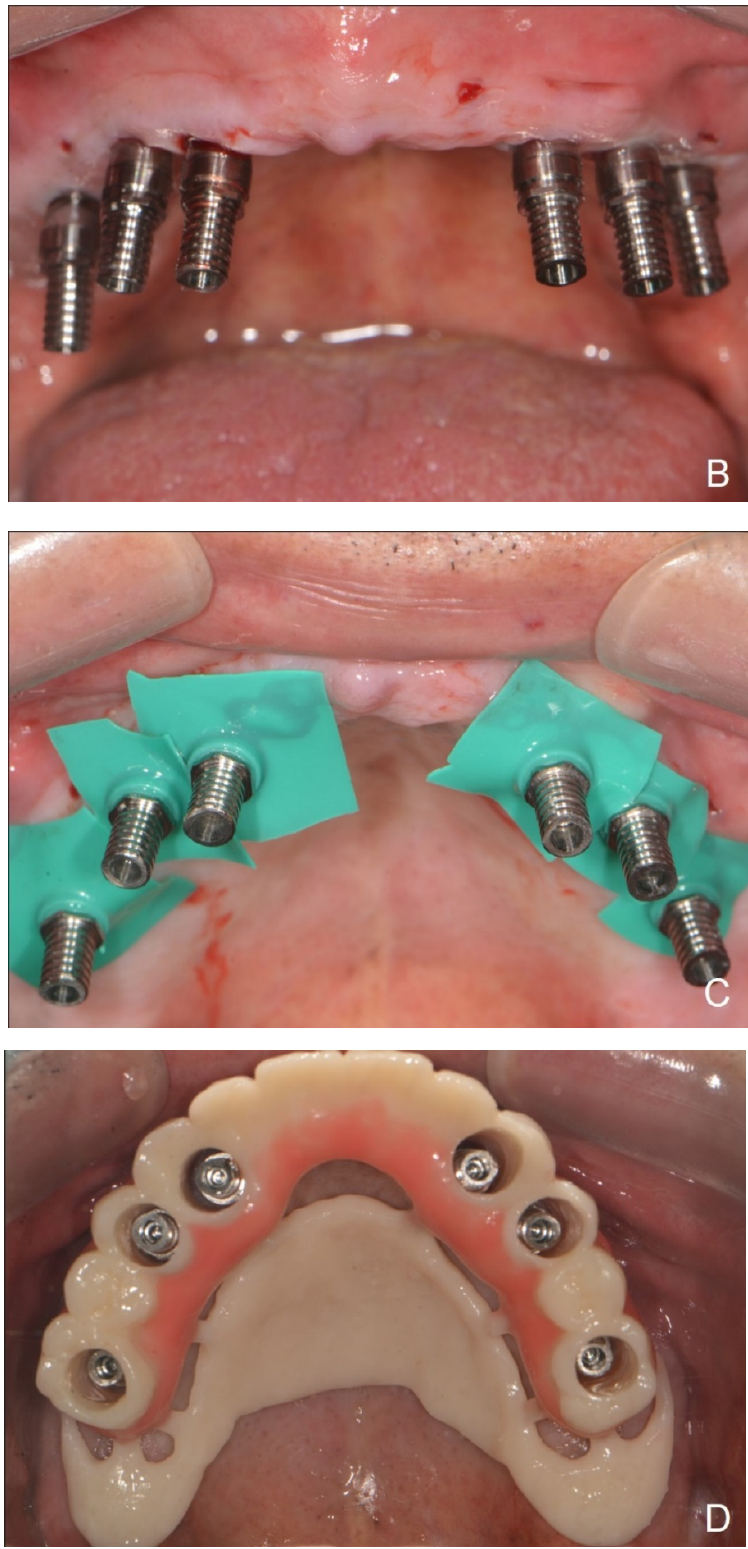
Figure 5. ( A ) Abutments in place. ( B ) Connection of the interim cylinders to the abutments. ( C ) Rubber dam placed beneath the interim cylinders to cover and protect the underlying soft tissue. ( D ) Evaluation of the interim restoration over interim cylinders.